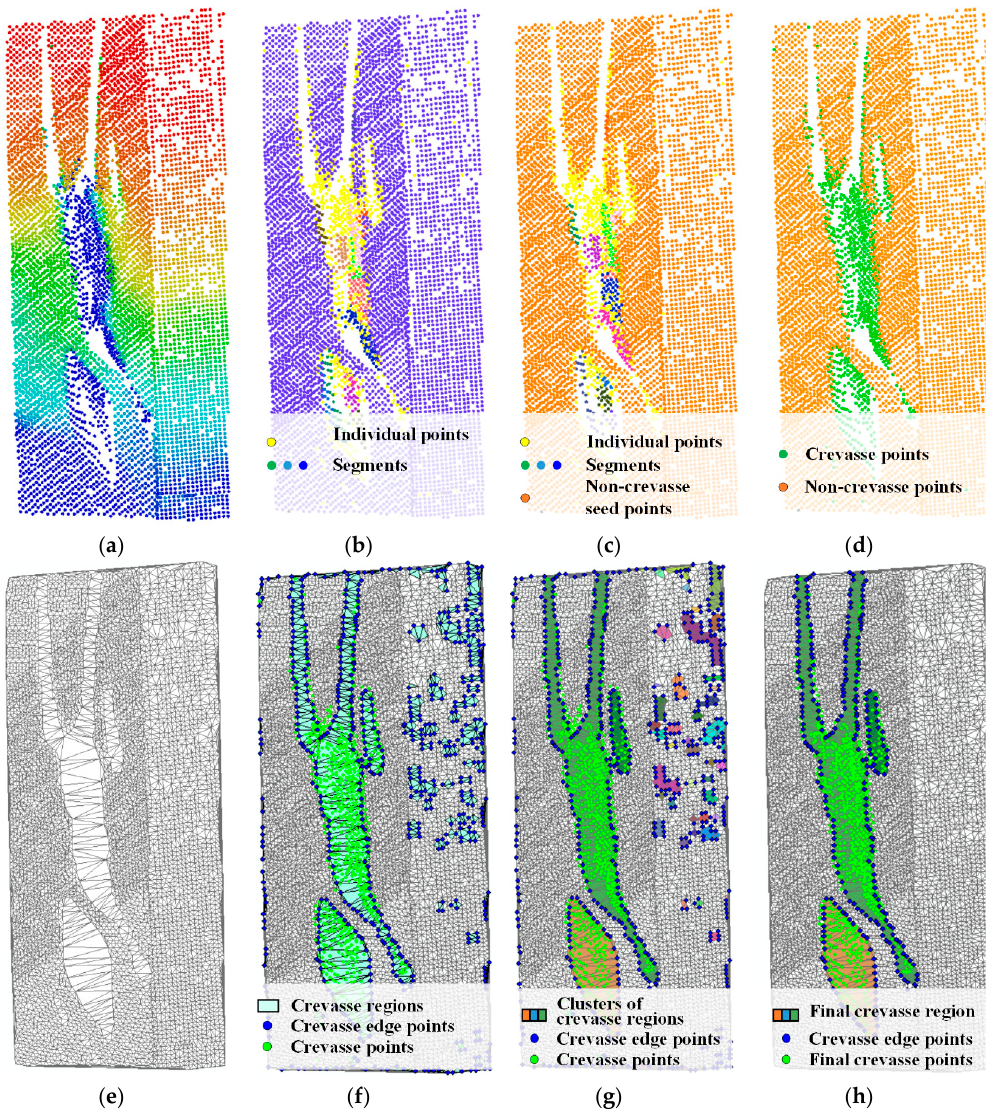
Figure 4. A real case for extracting crevasse points and edges. ( a ) Raw point cloud. ( b ) Representation of the point cloud based on the hybrid entities. ( c ) Extraction of the non-crevasse seed points. ( d ) Result of crevasse points extraction. ( e ) Generated Delaunay triangulation mesh of non-crevasse points. ( f ) Initial crevasse regions, crevasse edge points, and crevasse points. ( g ) Result of grouping the crevasse triangles. ( h ) Result of refining the extracted crevasse regions and points.